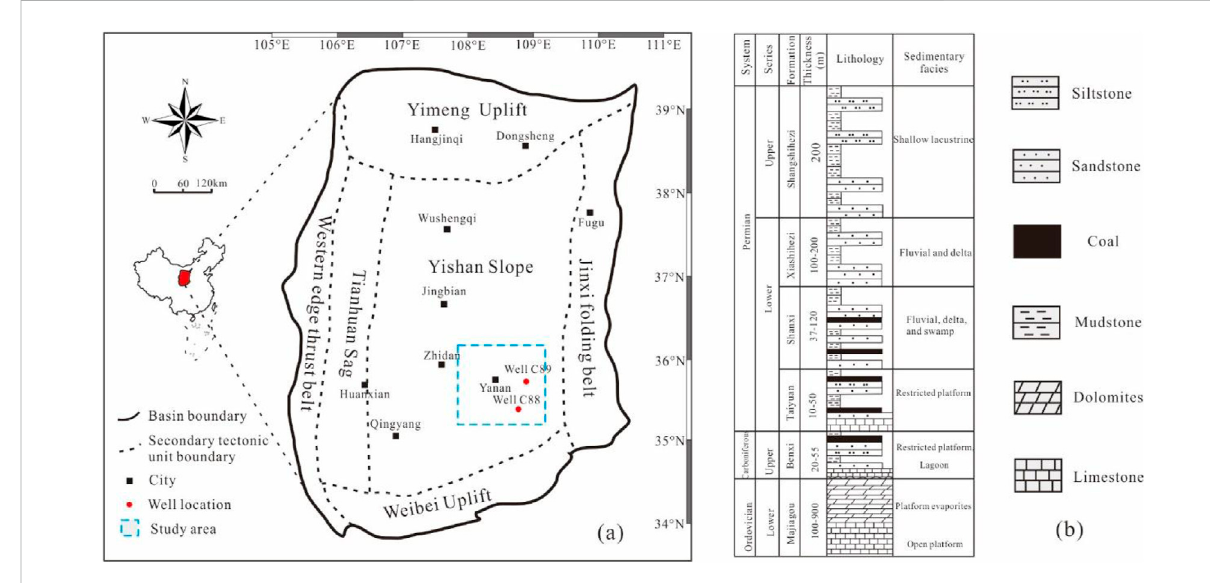
FIGURE 1 Locationandwelldistributionofthestudyarea (A) andgeneralizedstratigraphiccolumnoftheUpperPaleozoic,OrdosBasin (B) (Modi fi edafter Yang et al.,